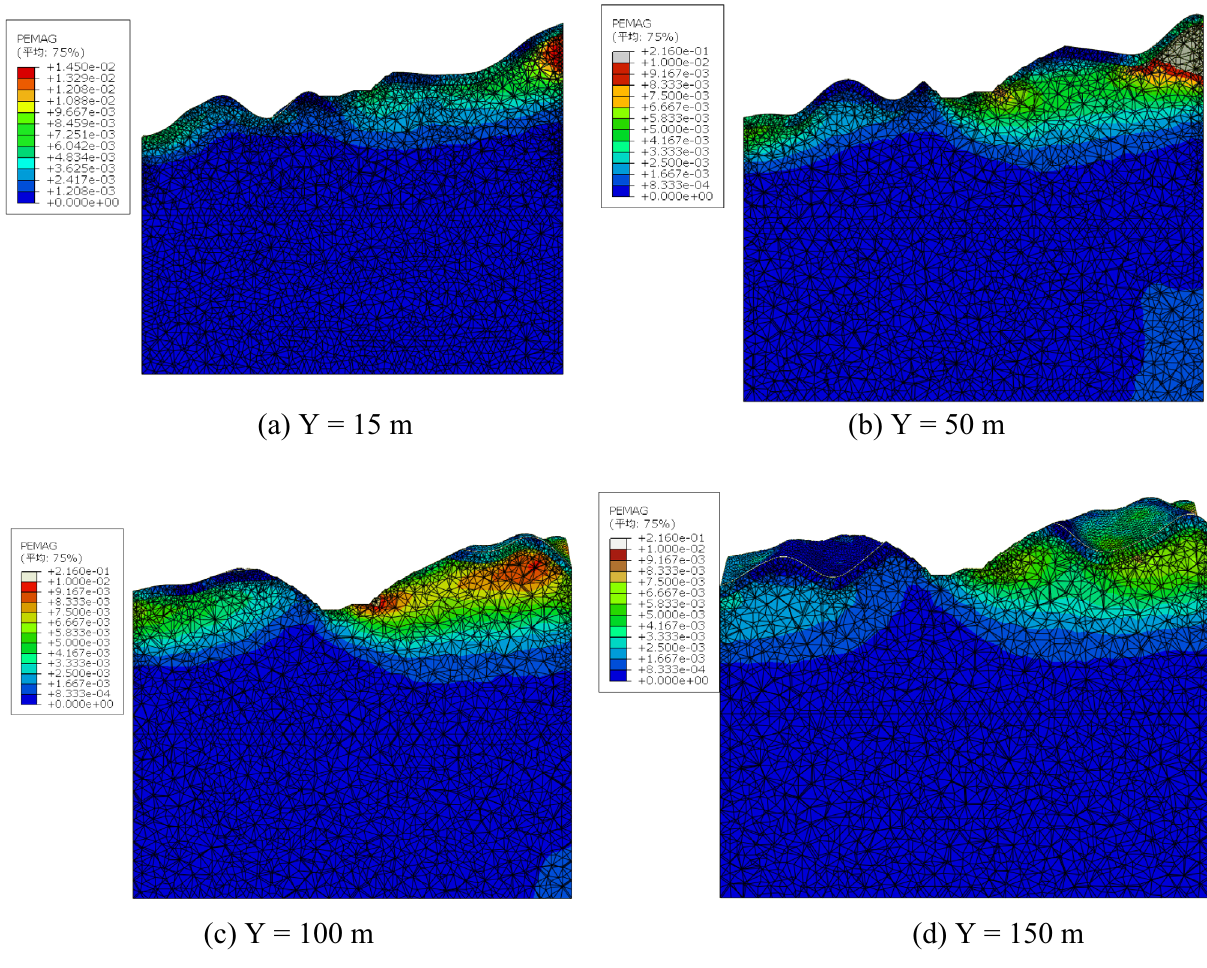
Figure 15. Contour of equivalent plastic strain.